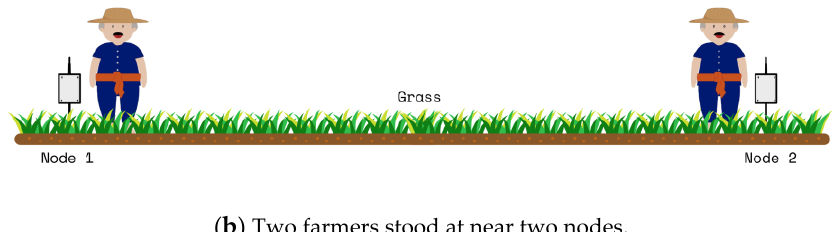
Figure 6. Blockage scenarios between the two nodes.